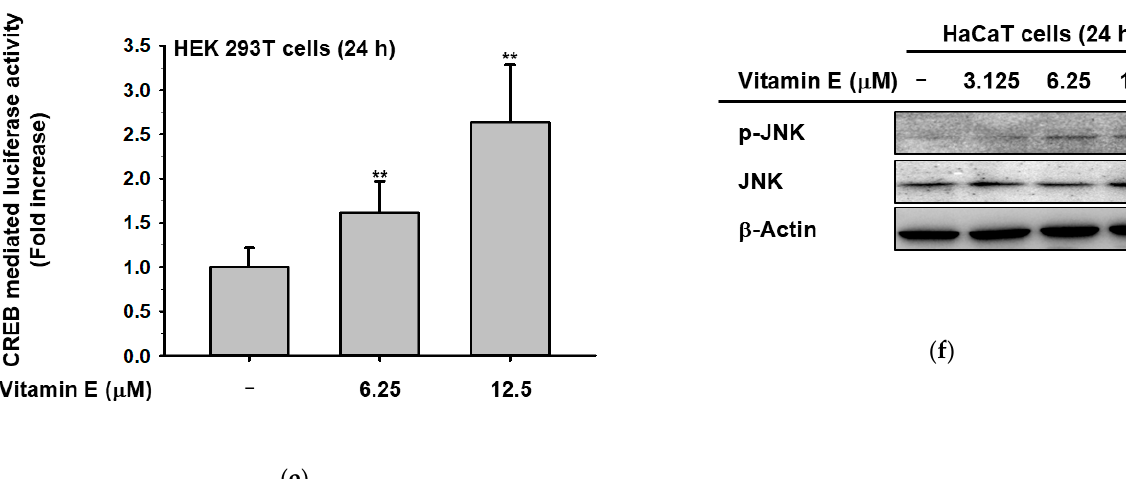
Figure 3. Effects of As-EE on MAPK-mediated AP-1 and CREB signaling pathway. ( a ) HEK293T cells transfected with CREB-Luc were incubated with As-EE for 24 h. A galactosidase construct was used as a control, and luciferase activity was measured using a luminometer; ( b , c ) HaCaT cells were incubated with As-EE for 24 h. Immunoblot analysis was used to evaluate the phosphorylation levels of c-Jun, c-Fos, p-CREB, and JNK; ( d ) RT-PCR was used to evaluate the expression levels of skin-barrier-related and hydration factors in HaCaT cells after treatment with vitamin E in a dose- dependent manner from 0 to 100 µM for 24 h; ( e ) Luciferase assay; ( f ) Phosphorylation level of JNK was measured with immunoblotting in HaCaT cells treated with vitamin E for 24 h. * p < 0.05 and ** p < 0.01 compared with the normal groups.